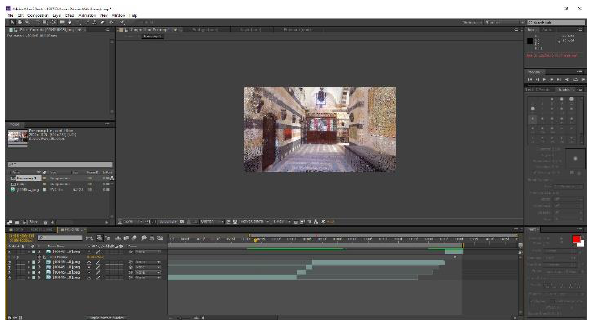
Figure 10. Al-‘Azm Palace – Adobe After Effects CS6